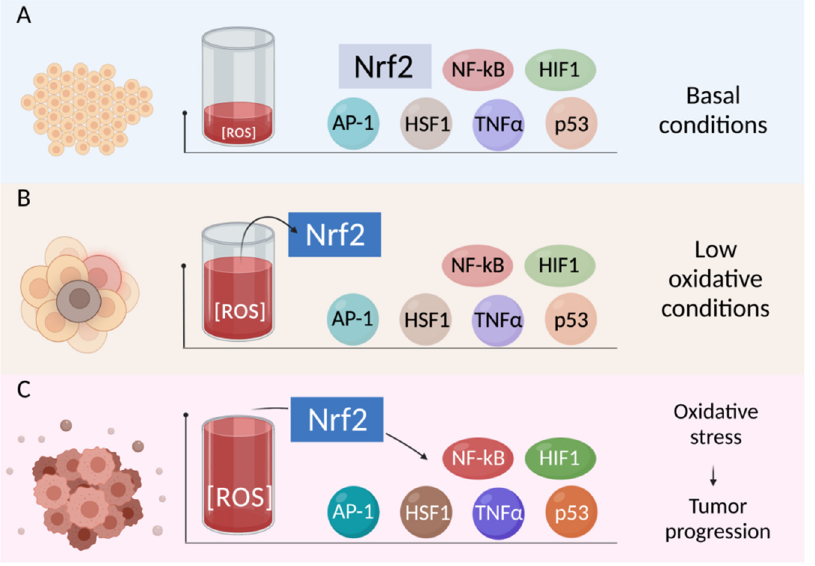
Figure 6. The role of Nrf2 in protecting the cell from oxidative stress. Under stress-free baseline conditions ( A ), the level of reactive oxygen species is maintained at a consistently low level due to the activity of antioxidants. However, with increased oxidative stress ( B ), Nrf2 activation, which ensures the adaptation of cells to an increase in ROS, as well as the induction of several genes that encode detoxification enzymes and antioxidants occur. If the ability of antioxidant systems induced by Nrf2 becomes insufficient to counteract additional oxidative stress ( C ) or oxidative stress proceeds for a long time, N2 suppression occurs. In addition, excessive ROS levels, which are not counteracted by Nrf2-directed protection, trigger additional redox triggers that activate other antioxidant transcription factors, which leads to various cellular responses, including metabolic reprogramming, damage repair, avoidance of apoptosis, and other features typical of tumor cells.